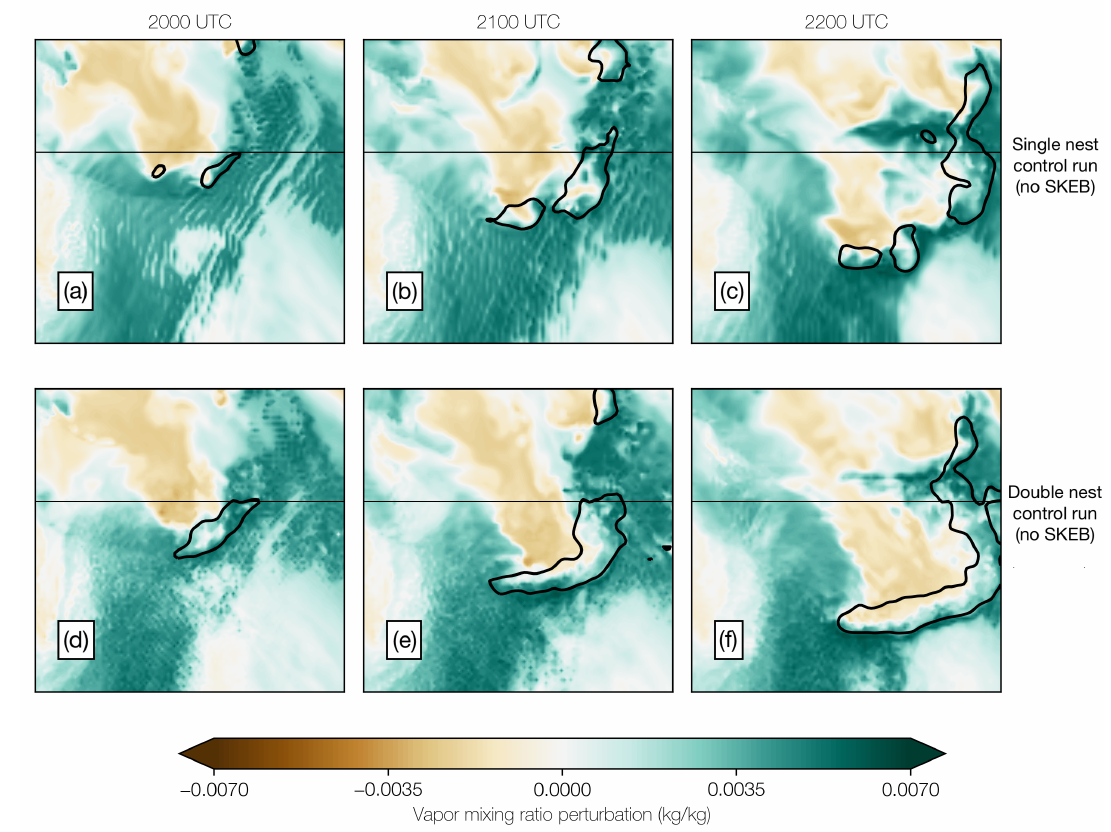
Figure 10. Perturbation water-vapor mixing ratio at 800 hPa (color-filled) taken from control members of single-nest ( a – c ) and double-nest ( d – f ) experiments. Black lines contour the 35dBZ composite reflectivity field, smoothed with a 9-km Gaussian filter, for reference. Fields shown at 20h ( a , d ), 21h ( b , e ), and 22h ( c , f ) simulation time. States shown in each panel are Nebraska (upper) and Kansas (lower), separated by the thin horizontal black